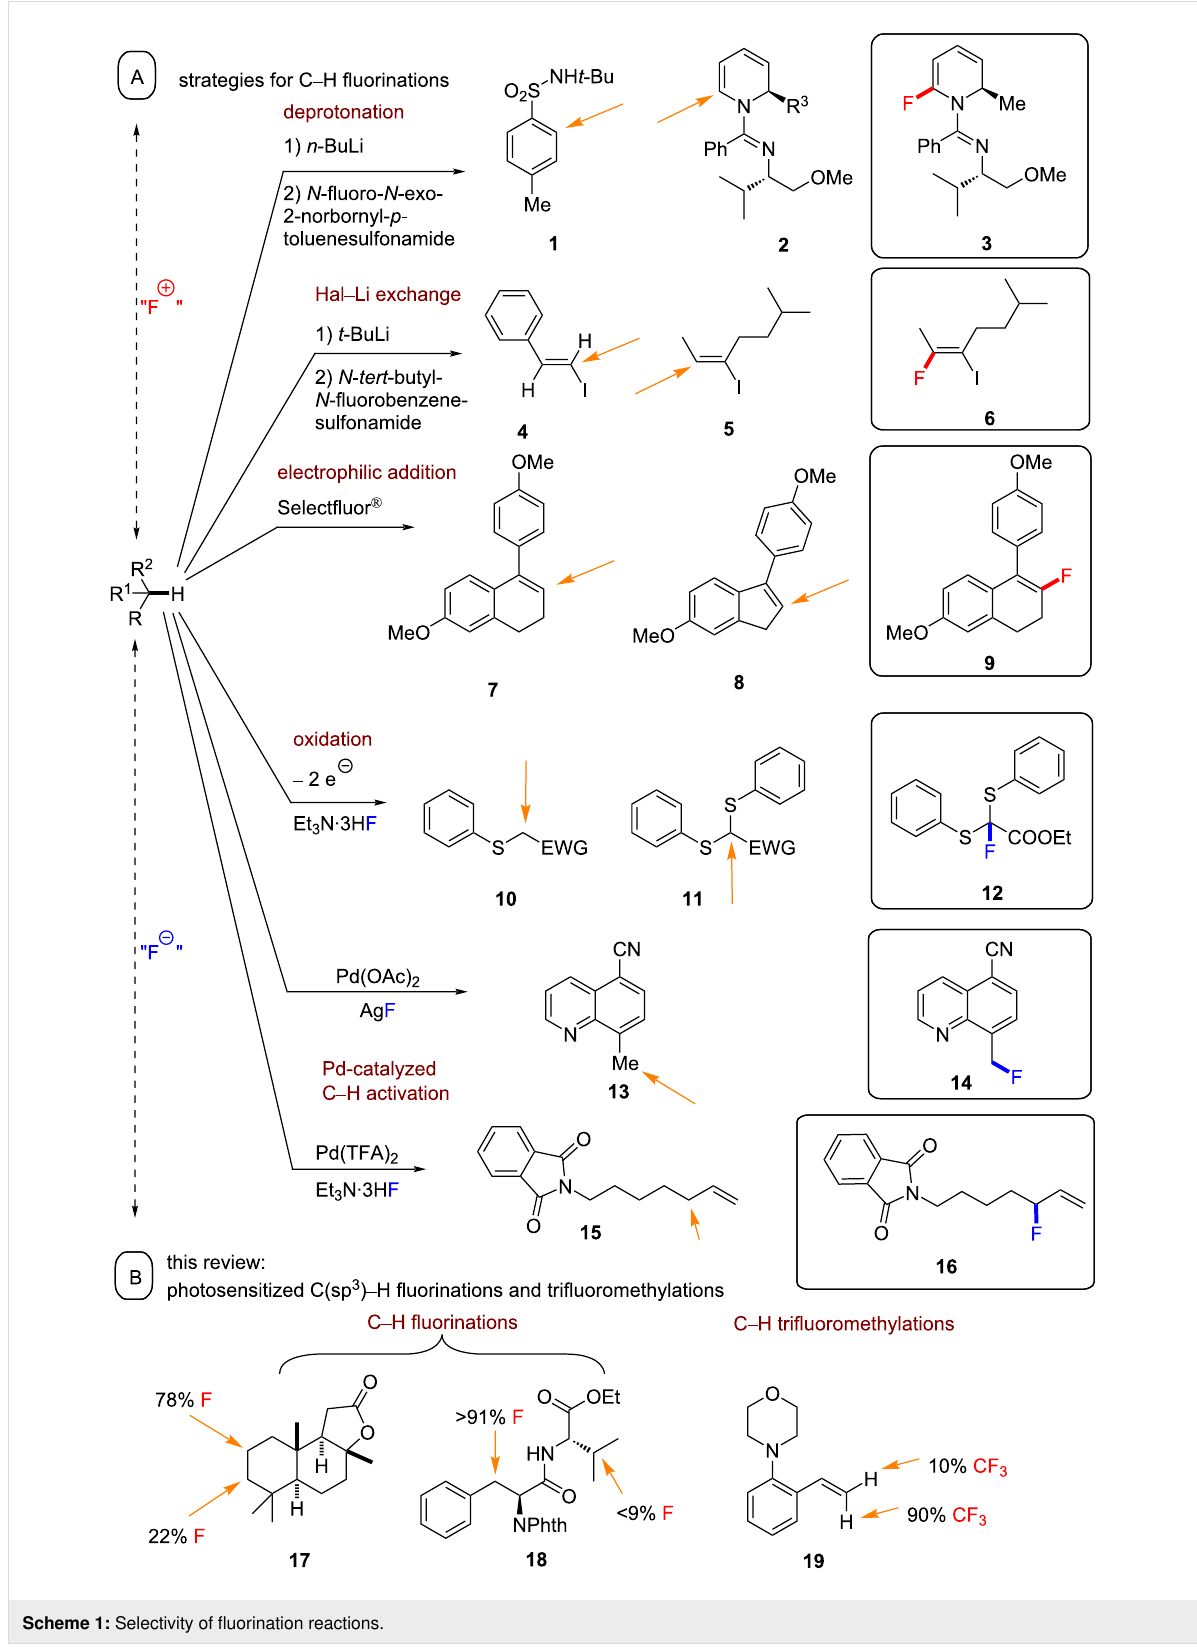
Scheme 1: Selectivity of fluorination